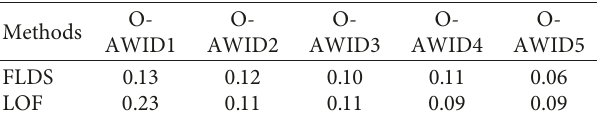
Table 3: The HTER measure of LOF and FLDS (the smaller, the better) for some extracted AWID data